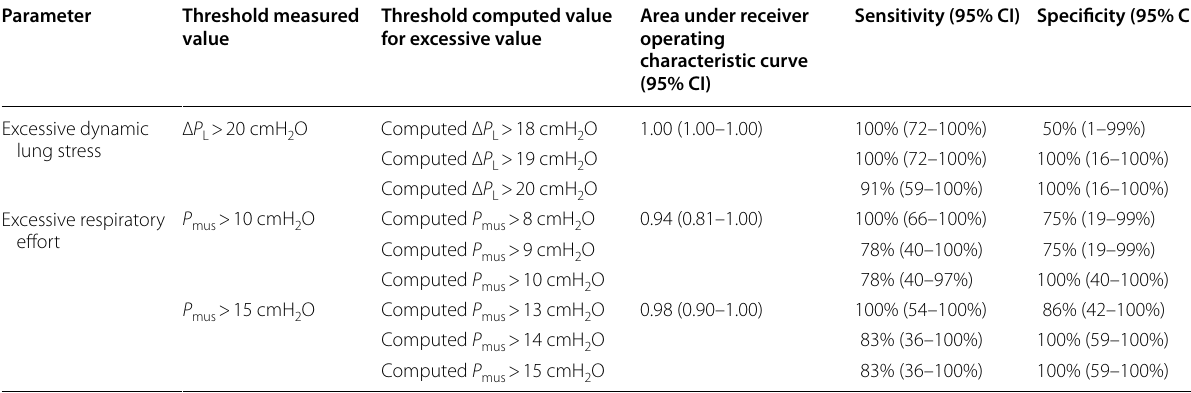
∆P L dynamic transpulmonary driving pressure, P mus respiratory muscle pressure